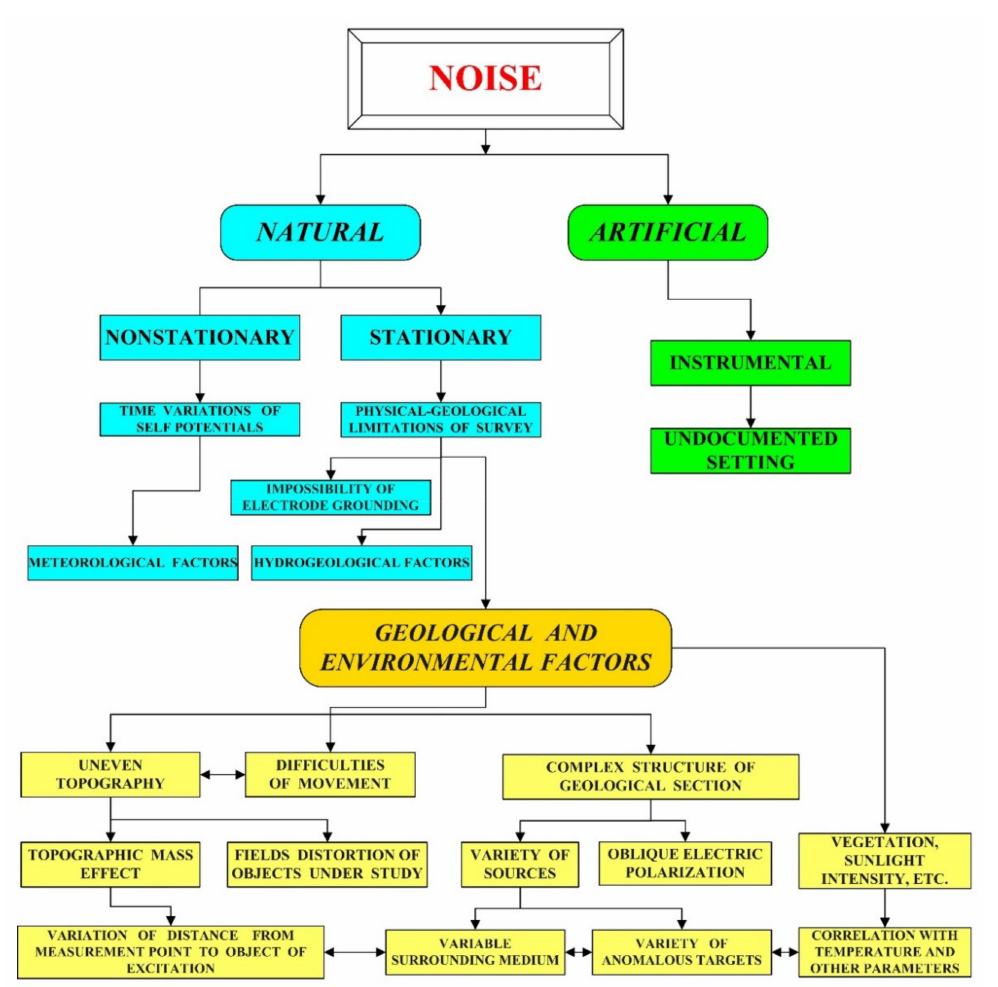
Figure 1. General scheme of disturbances in SP method (after [14], with